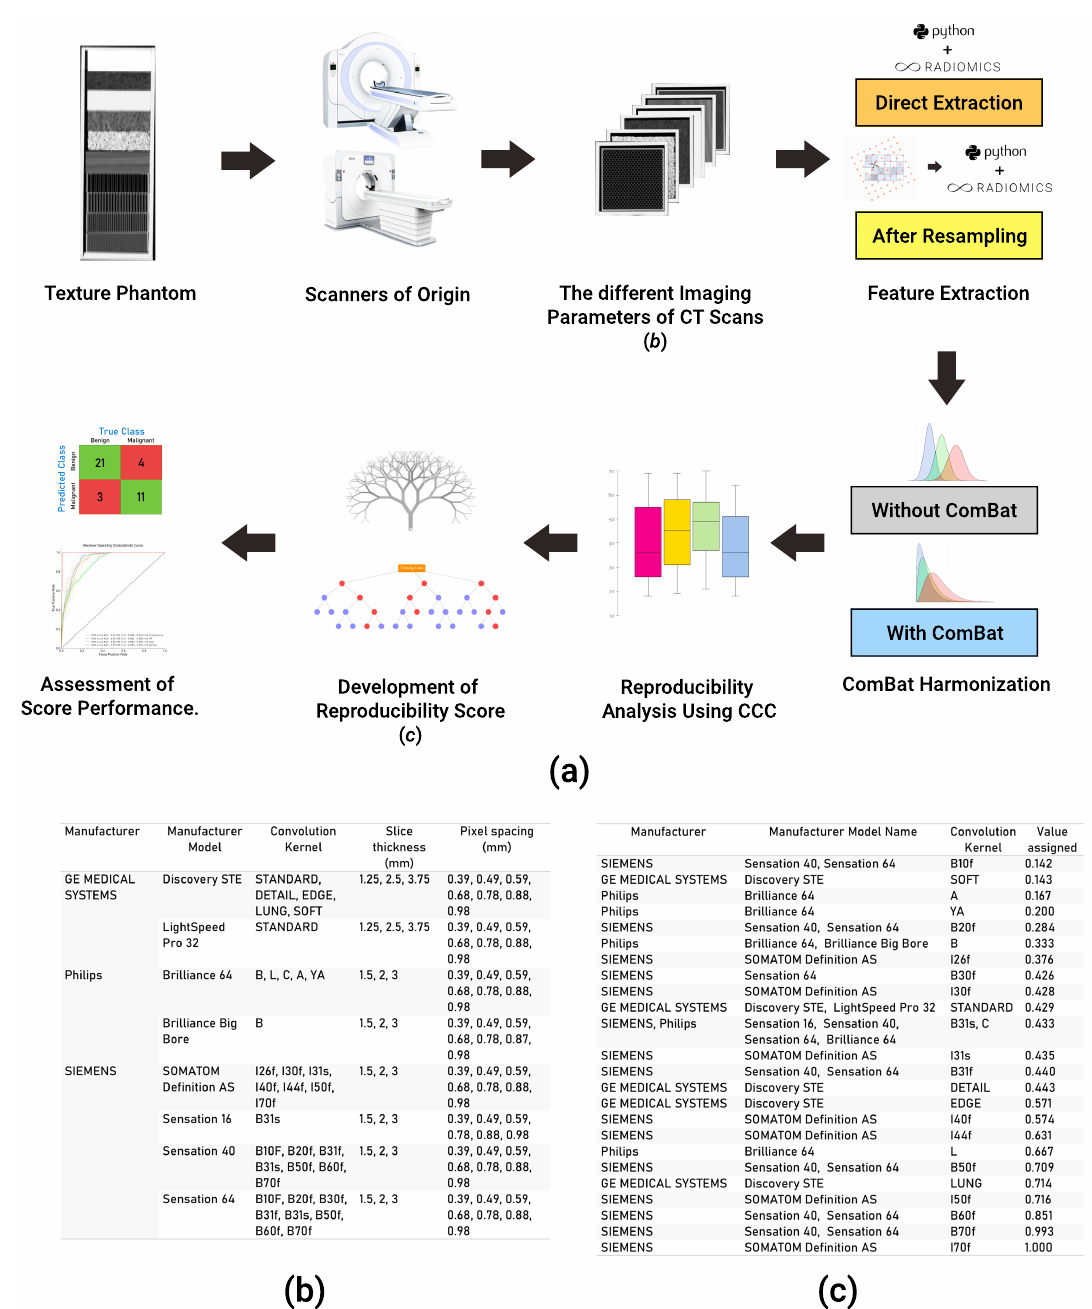
Figure 1. Explanatory diagram of our workflow. ( a ) The steps undertaken for data collection, analysis, and the development of the score; ( b ) a table showing different acquisition and reconstruction parameters of the phantom dataset; ( c ) a table showing the numeric value assigned to each kernel in the data